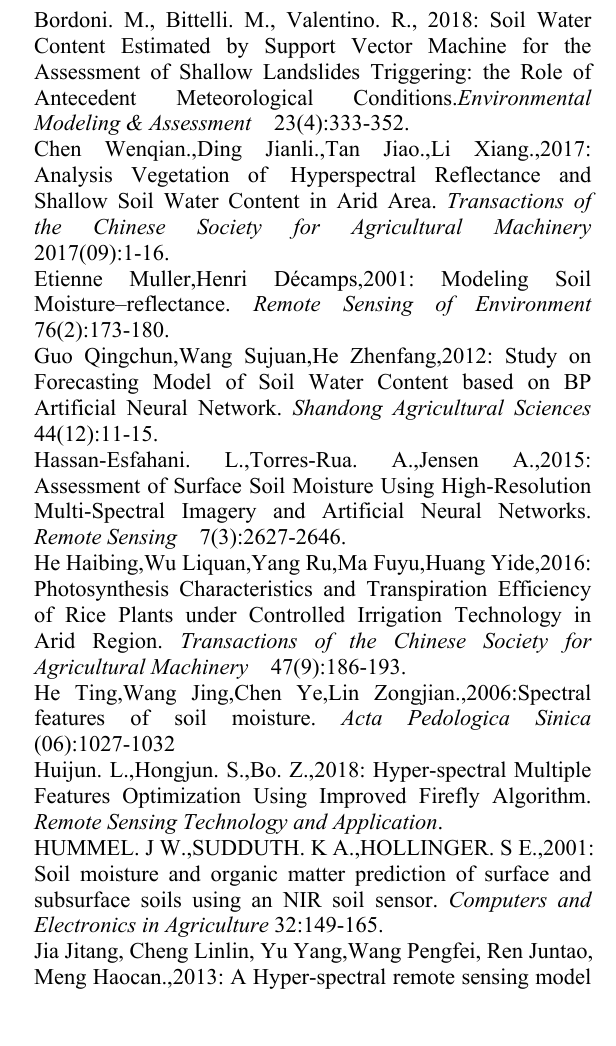
plough layer. Among the two indirect estimation